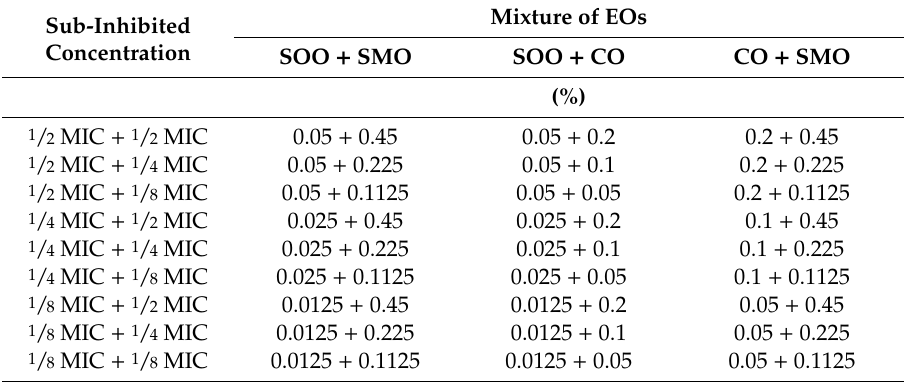
Table 1. Two-component mixtures of essential oils in